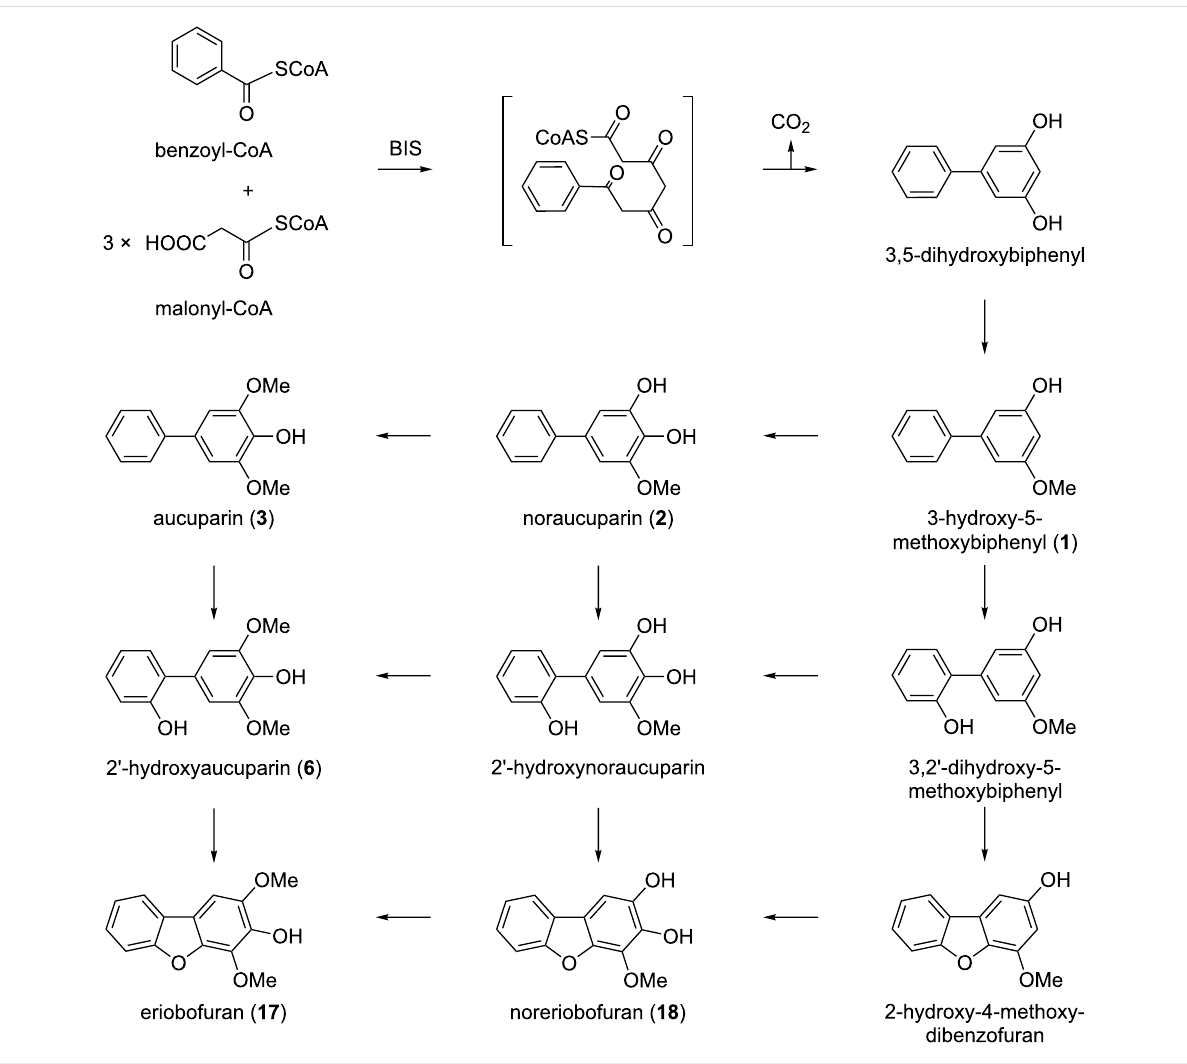
Figure 4: Established formation of 3,5-dihydroxybiphenyl by biphenyl synthase (BIS) [34] and proposed biosynthetic reactions leading to biphenyl and dibenzofuran phytoalexins in elicitor-treated S. aucuparia cell cultures